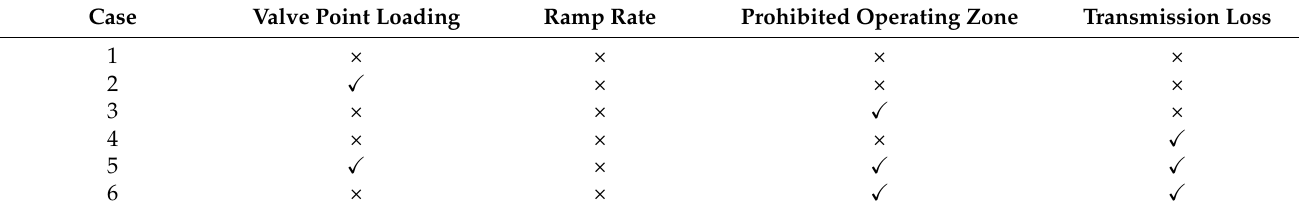
Table 1. Multi-fuel system undertaken for the study, P D = 2700 MW